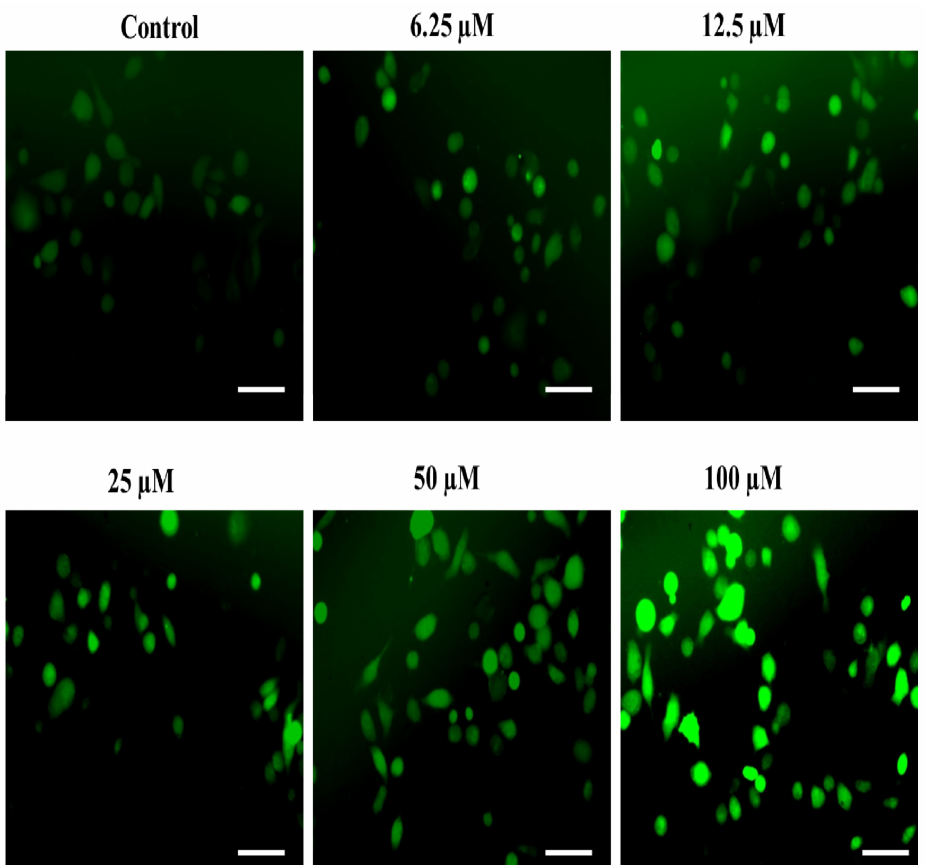
Figure 8. The substituted SOX ( 4a ) triggers ROS generation in PC-3 cells . For the detection of ROS- specific fluorescence, PC-3 cells seeded in each well were treated with 0.0 to 100 µ M substituted SOX ( 4a ) for 24 h, and the cells were then stained with 10 µ M DCFH-DA and incubated for half an hour and imaging was done using a FLoid TM imaging station, Thermo-Scientific, Waltham, MA, USA. Scale bar: 100 µ